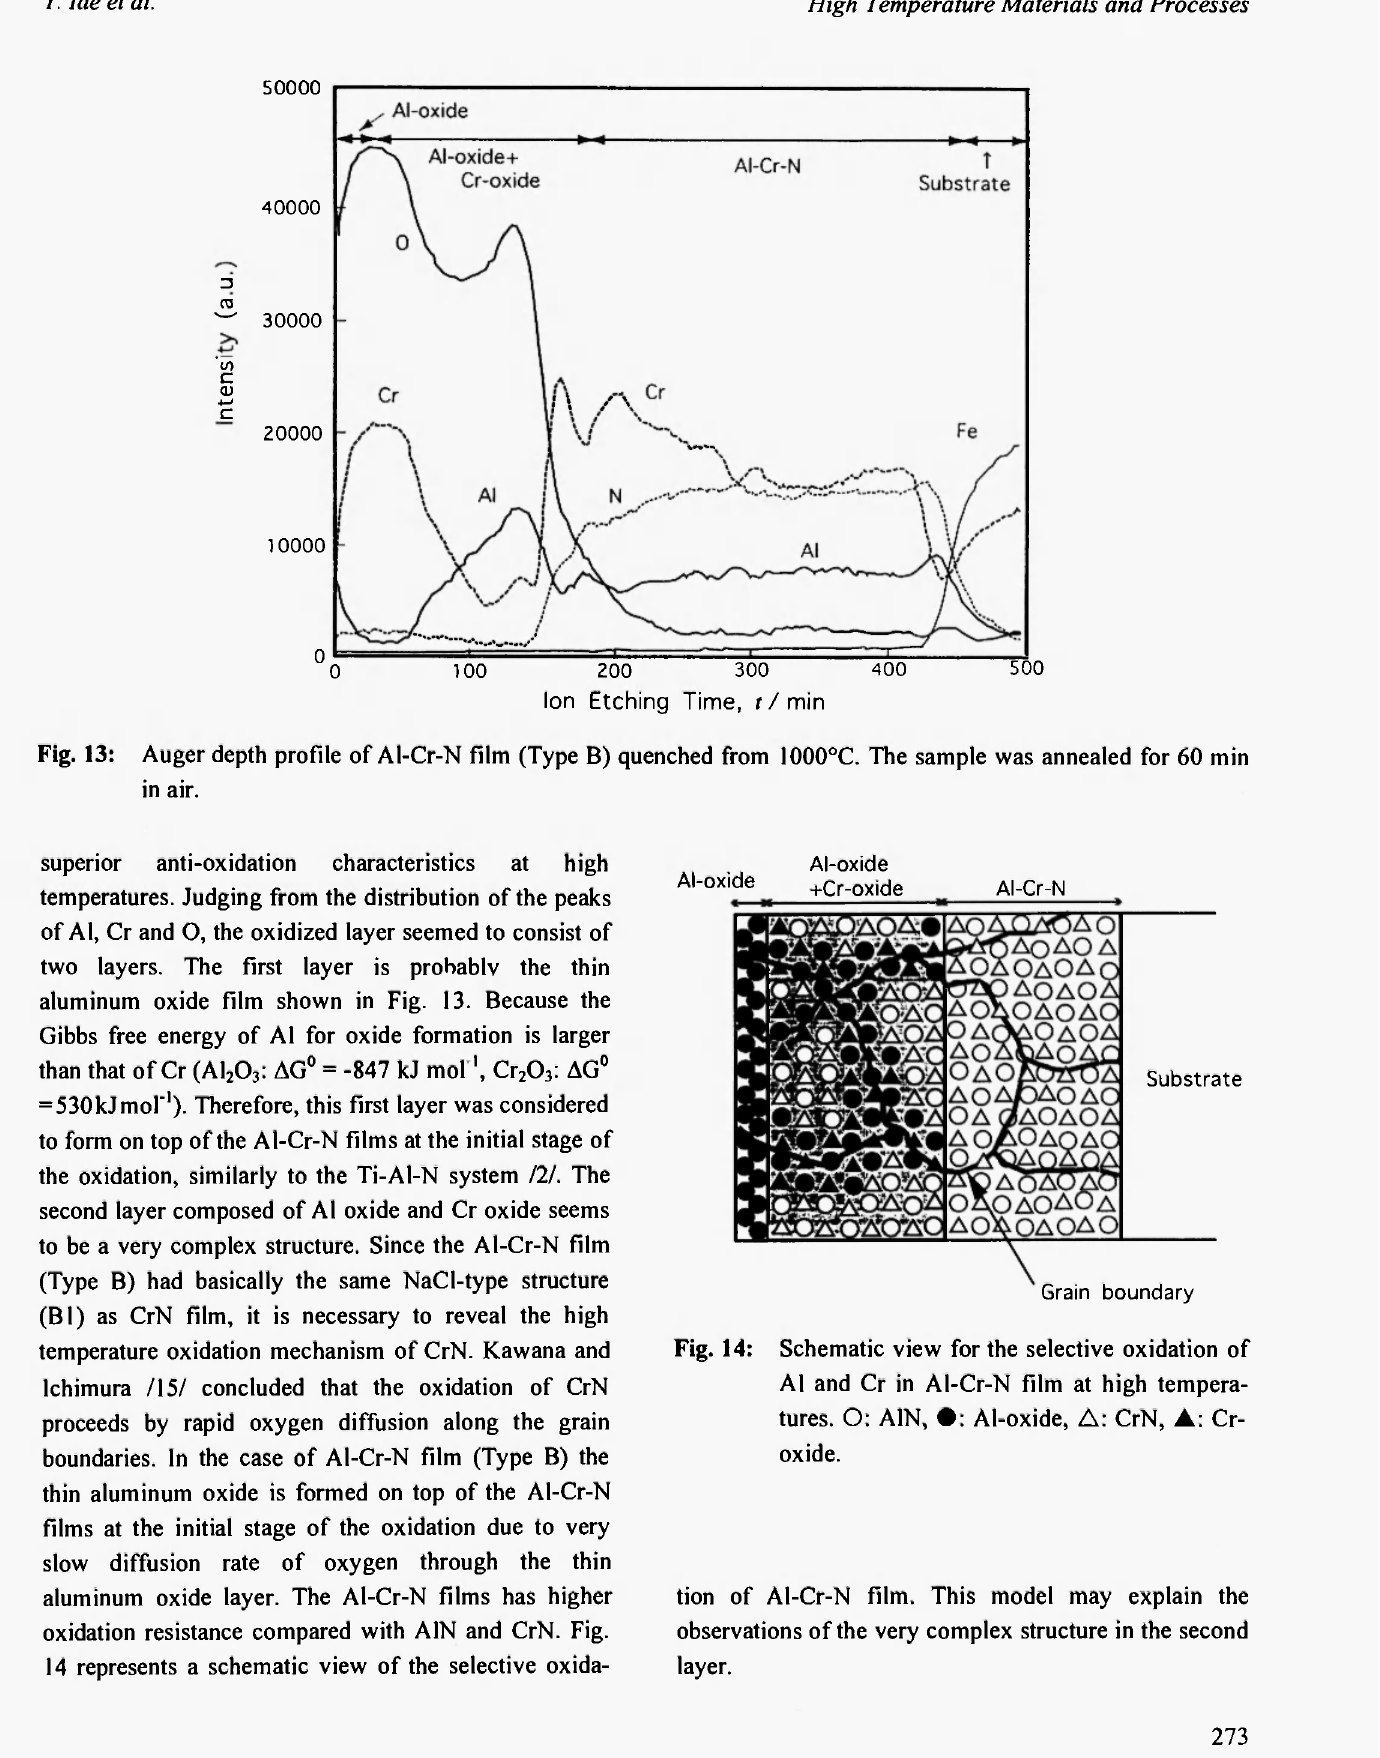
Fig. 14: Schematic view for the selective oxidation of Al and Cr in Al-Cr-N film at high tempera- tures. Ο: AIN, ·: Al-oxide, Δ: CrN, •: Cr-